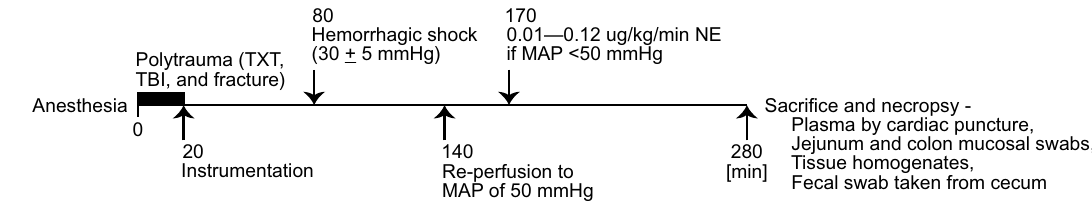
Figure 1. The experimental timeline for the murine polytrauma (PT) with hemorrhagic shock (HS) model. All mice were randomly subjected to PT, HS, PT + HS, or sham-catherization procedures ( N = 36; n = 8 per group, PT, HS, Sham; n = 7 per group, PT + HS). Untreated control mice (Ctrl, n = 5) are not shown here. Briefly, all mice were anaesthetized with 2.5–3% sevoflurane in oxygen. Ctrl animals were euthanized directly after induction of anesthesia. Mice in the PT and PT + HS groups were subjected to thoracic trauma/blunt bilateral chest trauma (TXT), closed head injury (TBI), and a distal femur fracture accompanied by soft tissue injury. At 20 min, mice in the Sham, HS, and PT + HS groups were catheterized in the left femoral artery to monitor blood pressure and induce sham procedures or HS; a jugular vein catheter was also inserted for reperfusion following blood loss. At the 80 min time point, mice in the HS and PT + HS groups were bled for 5–10 min to reach a mean arterial pressure (MAP) of 30 ± 5 mmHg which was kept stable for 60 min. At 140 min, mice in the HS and PT + HS groups were reperfused through the jugular vein with a balanced electrolyte solution over 30 min, using a fourfold volume calculation of the blood drawn to induce HS. Mice that failed to recover a MAP of 50 mmHg were additionally supported by a predetermined anesthesia adjustment and norepinephrine support protocol, by which the goal MAP of 50 mmHg was attained. MAP mean arterial pressure, NE norepinephrine, PT polytrauma, TBI traumatic brain injury, TXT thoracic trauma/blunt bilateral chest